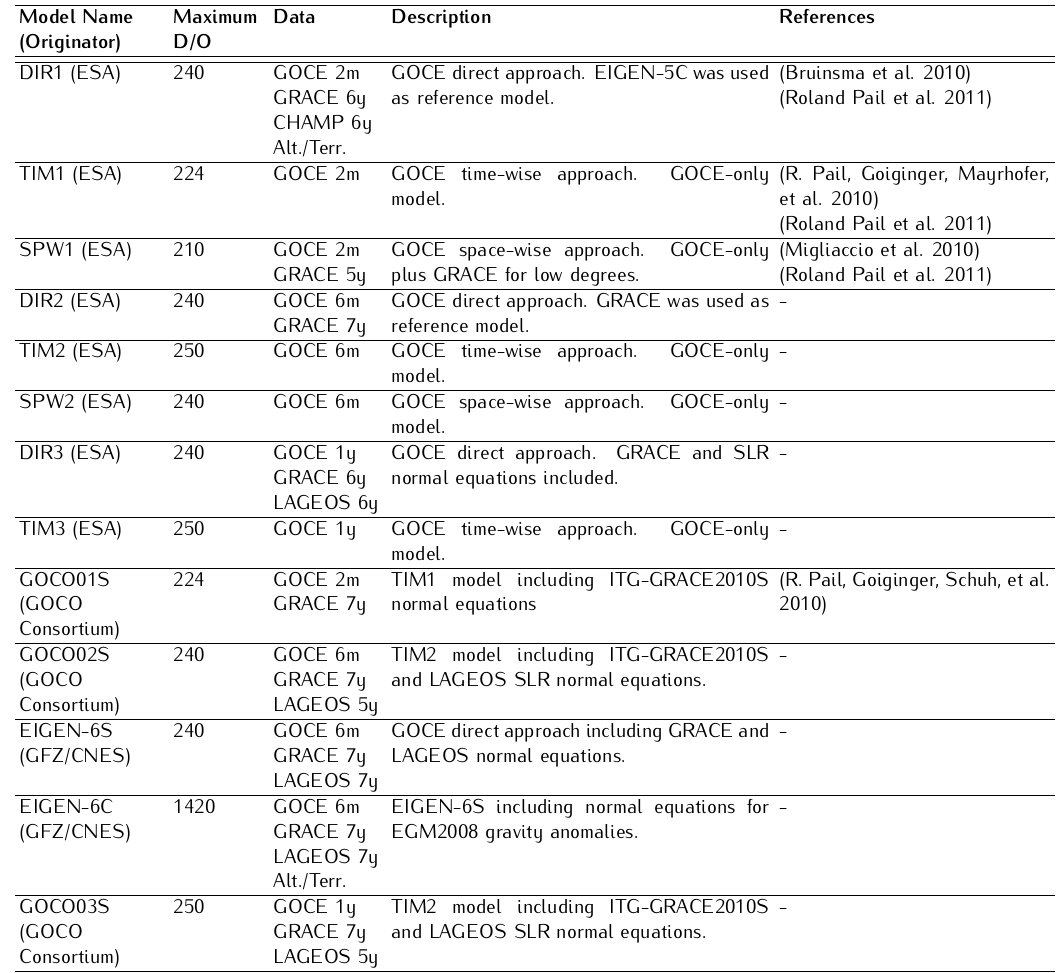
Table 1. GOCE and GOCE-GRACE combined gravity field models (taken from Gruber et al.,